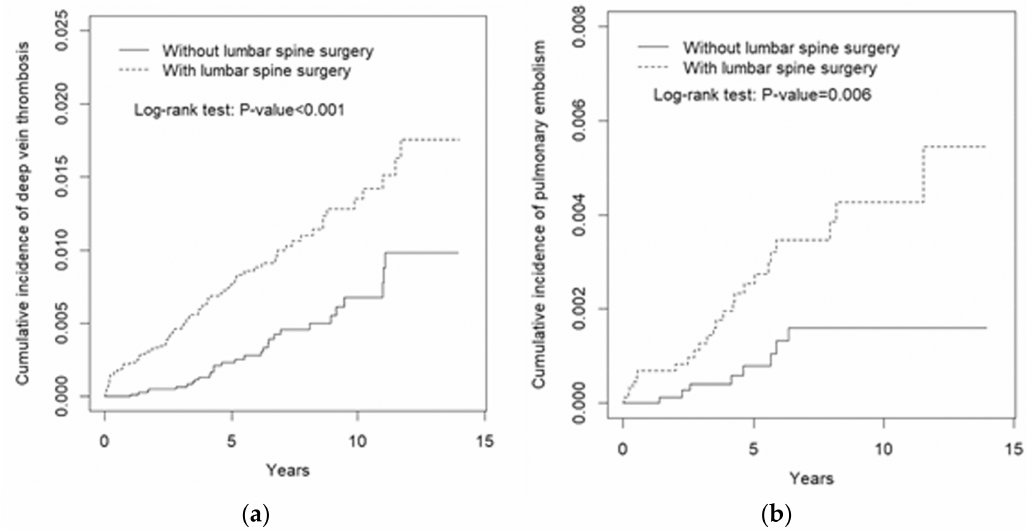
Figure 1. Cumulative incidence of ( a ) deep vein thrombosis and ( b ) pulmonary embolism in patients with thoracolumbar spine surgery and those without thoracolumbar lumbar spine